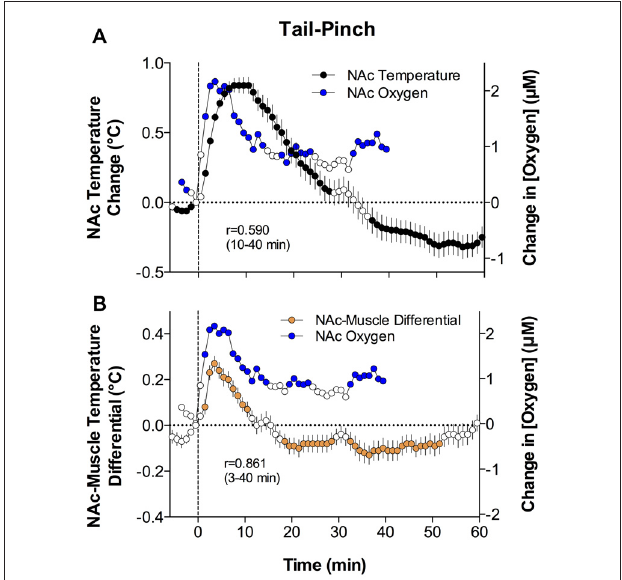
FIGURE 4 | Relationships between changes in NAc oxygen and temperature parameters induced by tail-pinch. Panel (A) shows mean ( ± SEM) changes in NAc oxygen concentration (blue circles) and NAc temperature (black circles) analyzed with slow, 1-min time resolution. Panel (B) shows mean ( ± SEM) changes in NAc oxygen concentration (blue circles) and the NAc-Muscle temperature differential (orange circles) analyzed with slow, 1-min time resolution. Values significantly different from baseline are shown as filled symbols. Vertical hatched lines show onset of tail-pinch. Each graph shows coefficients of correlation (r) for compared parameters during specified time intervals following the onset of tail-pinch. Original data were published in Solis et al. (2017a).